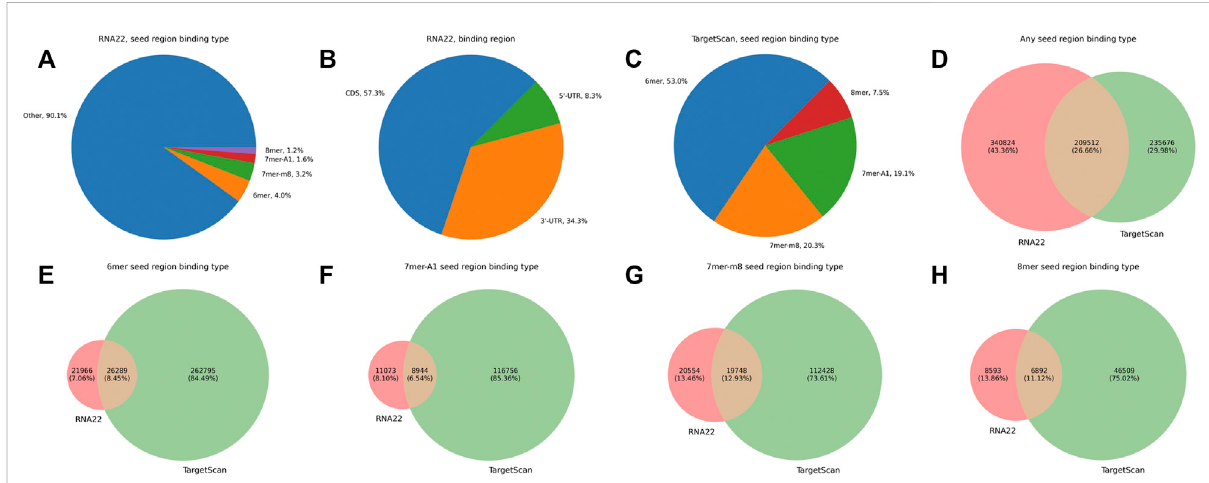
FIGURE 2 ComparisonofRNA22-andTargetScan-predictedisomiR-mRNAinteractions. (A) percentagesofdifferentseedregionbindingtypesinRNA22- predicted interaction sites. (B) percentages of different mRNA regions in RNA22-predicted interaction sites. (C) percentages ofdifferent seed region binding types in TargetScan-predicted interaction sites. (D) the mutual arrangement between the sets of predicted isomiR-mRNA interactions (not individual interacting sites) by RNA22 and TargetScan. (E – H) : the mutual arrangement between the sets of RNA-22 and TargetScan-predicted isomiR-mRNA interactions containing speci fi c seed region binding sites (6mer, 7mer-A1, 7mer-m8, 8mer). For constructing plots (D – H) , we considered only these transcripts which were included in the input of both RNA22 and